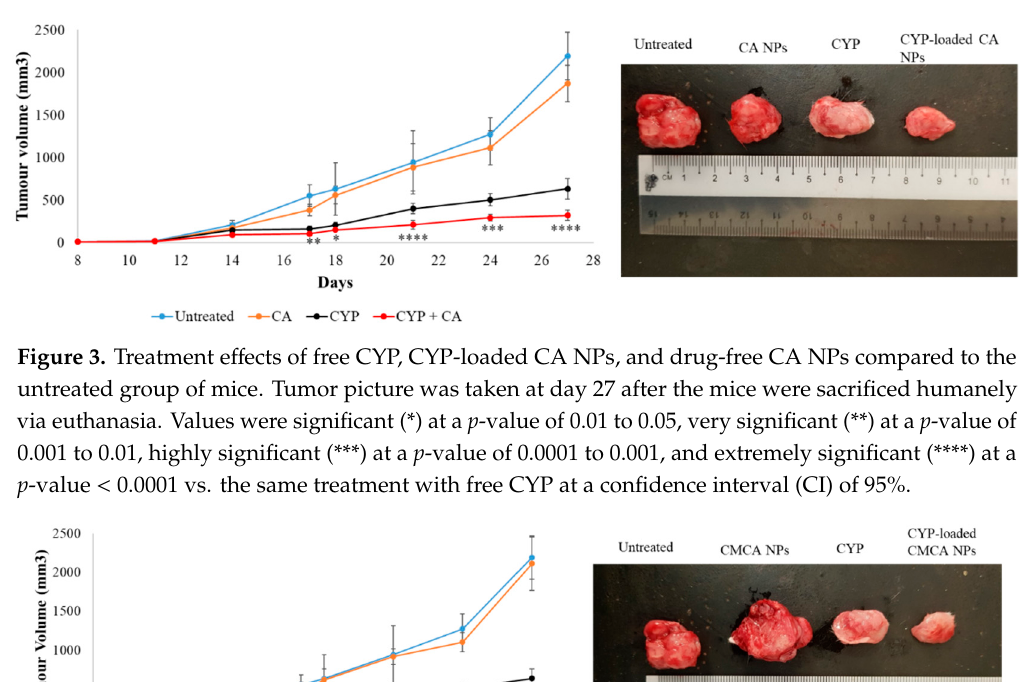
Figure 2. Breast cancer mouse model. ( A ) Murine breast cancer model established by injecting 4T1 cells subcutaneously on the mammary pad of mice ( n = 5). ( B ) Body weight (BW) curves for 25 days during tumor inoculation and treatment. ( C ) Different organ weights of healthy, untreated, free CYP and CYP-loaded NP-treated mice groups at day 27 after the mice were sacrificed humanely via euthanasia. Drug-free CA NPs, CMCA NPs, and α -KAMCA NPs were injected intravenously into the tumor-